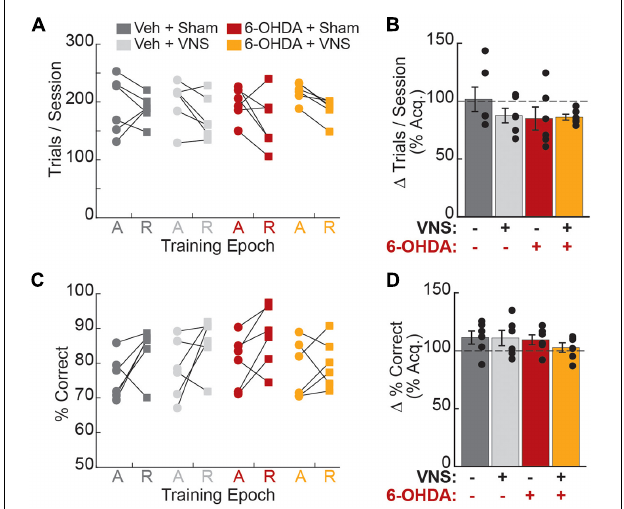
FIGURE 3 | 6-OHDA administration did not affect behavioral performance. (A) The average trials performed per session did not differ across treatment groups during the acquisition (A, circles) or recovery (R, squares) training epochs. (B) Average trials performed was not impacted by 6-OHDA infusions or VNS group assignment. (C) The percentage of rewarded trials per session did not differ across treatment groups during acquisition or recovery epochs. (D) Percent correct performance was not impacted by 6-OHDA infusions or VNS group assignment. In (B,D) , recovery period performance is plotted as a percent of acquisition (Acq.) performance. Legend for all plots is shown in (A)